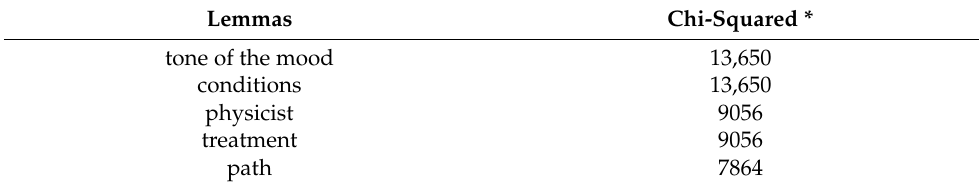
Table 3. Theme analysis of the transcript